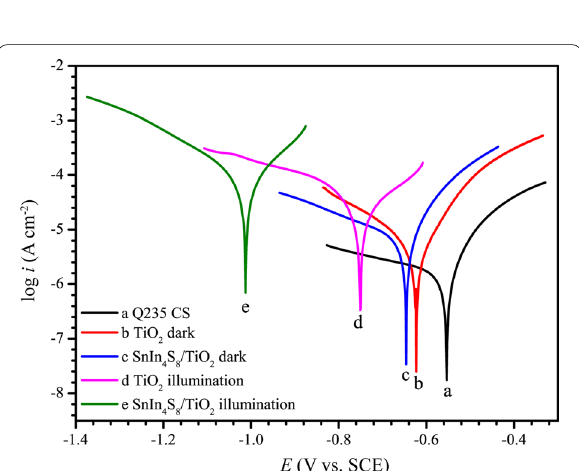
in the dark, SnIn 2 under illumination, and SnIn 2